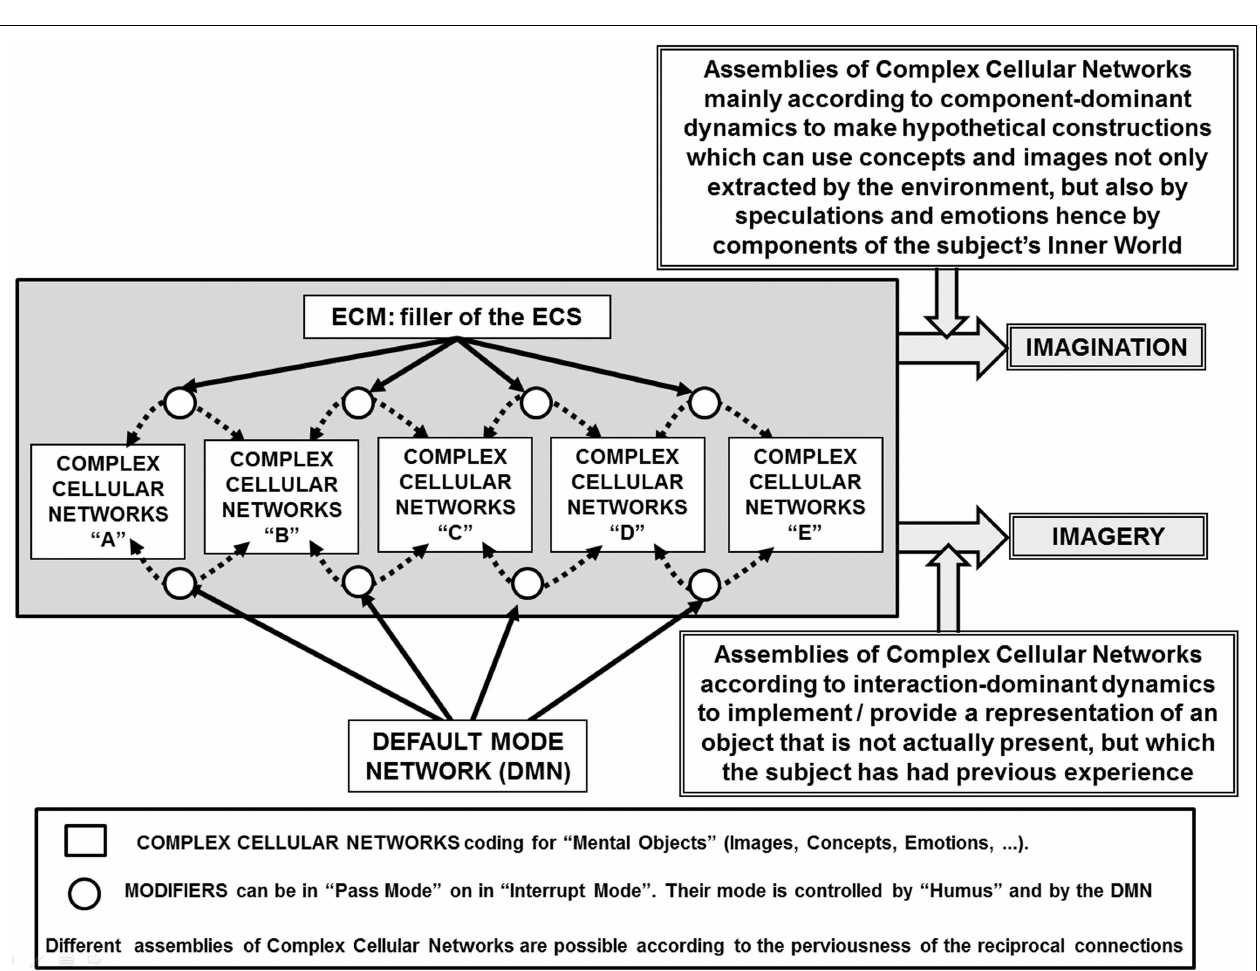
figure and discussed in the paper. It is also indicated the extracellular matrix (ECM) as filler of the extracellular space (ECS) that can have a role in modulating the assembling of neuronal groups and their intercellular interactions (Agnati et al.,